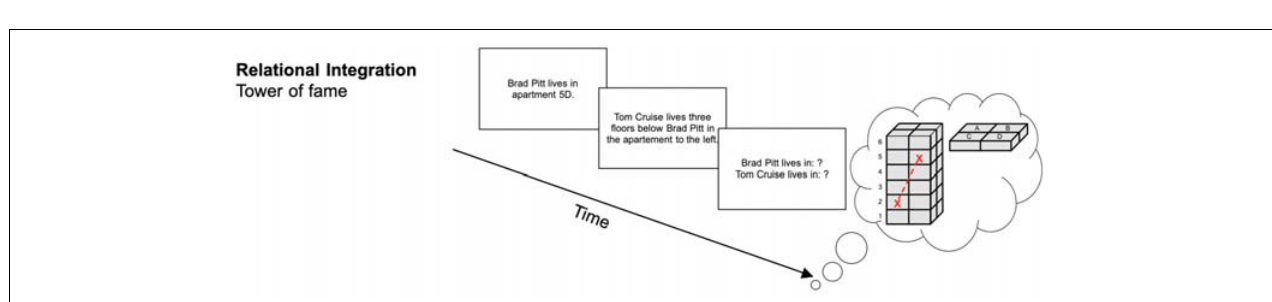
FIGURE 1 | Storage and processing task (complex span) (reused and adapted with permission from Langer et al., 2013). Participants had to memorize the blue digits which were interrupted by a distractor item on which they needed to judge the parity (Langer et al., 2013; von Bastian et al., 2013a).